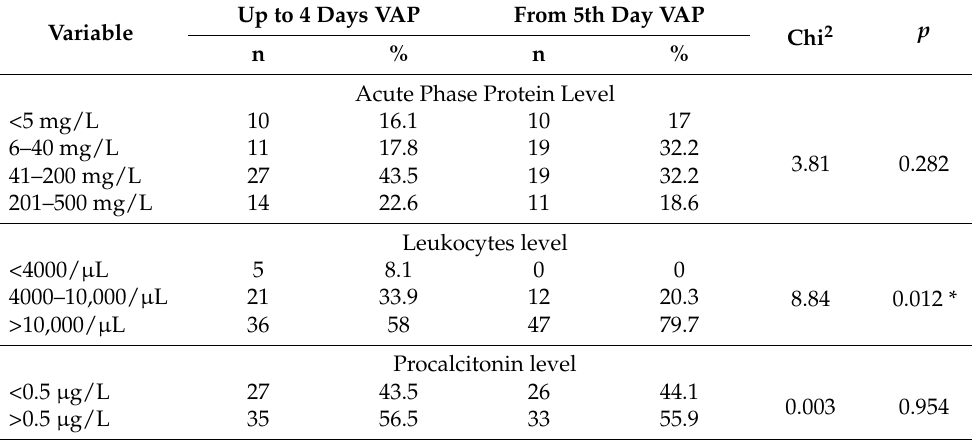
Table 7. The correlation between selected inflammation indicators and VAP contraction time.